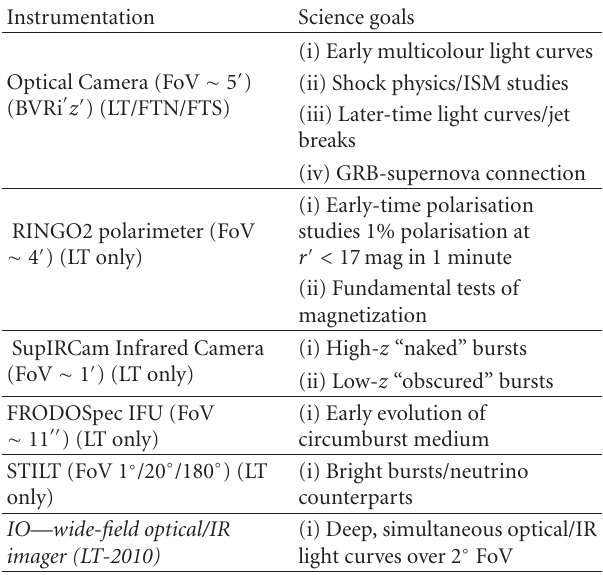
Table 1: Current instrumentation on the Liverpool and Faulkes telescopes and associated GRB science goals; upcoming instrumen- tation is shown in